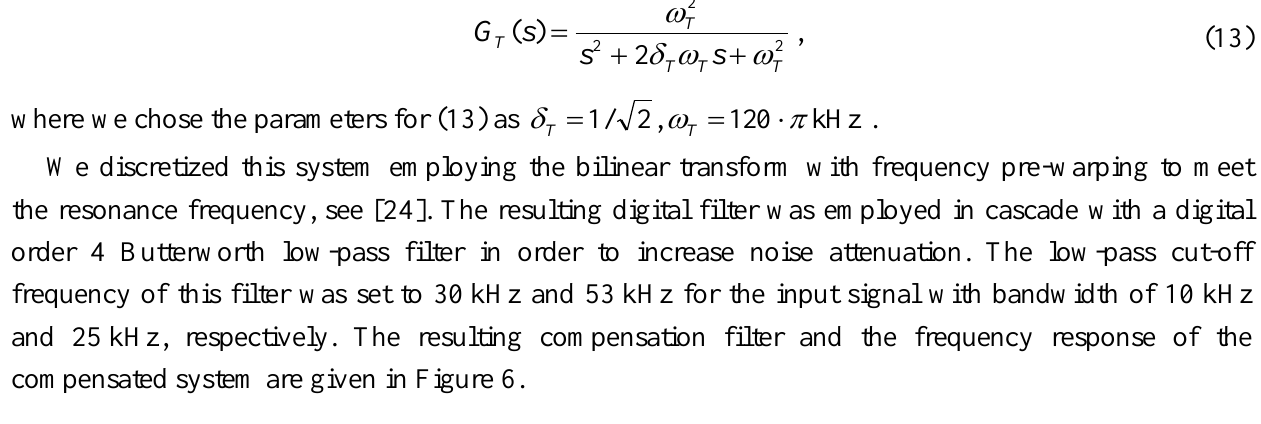
Figure 6. Left: Frequency response of the sensor model (black) with system parameter vector (11) and the IIR compensation filter (green) designed for the available estimate (12a) of the system parameter vector for estimation of the broad-banded (25 kHz) input signal. Right: Frequency response of the actual compensated